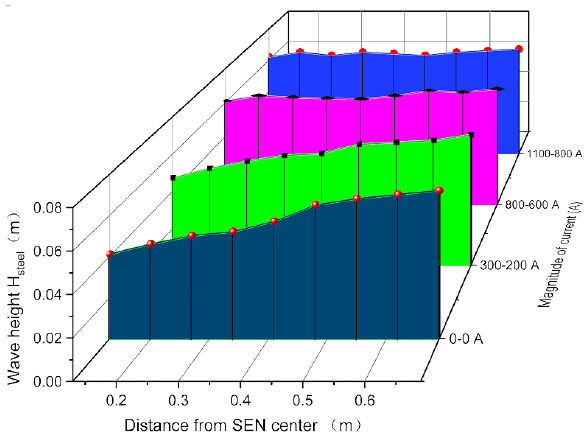
Figure 21. Liquid-level waveform on the centerline of the wide face.